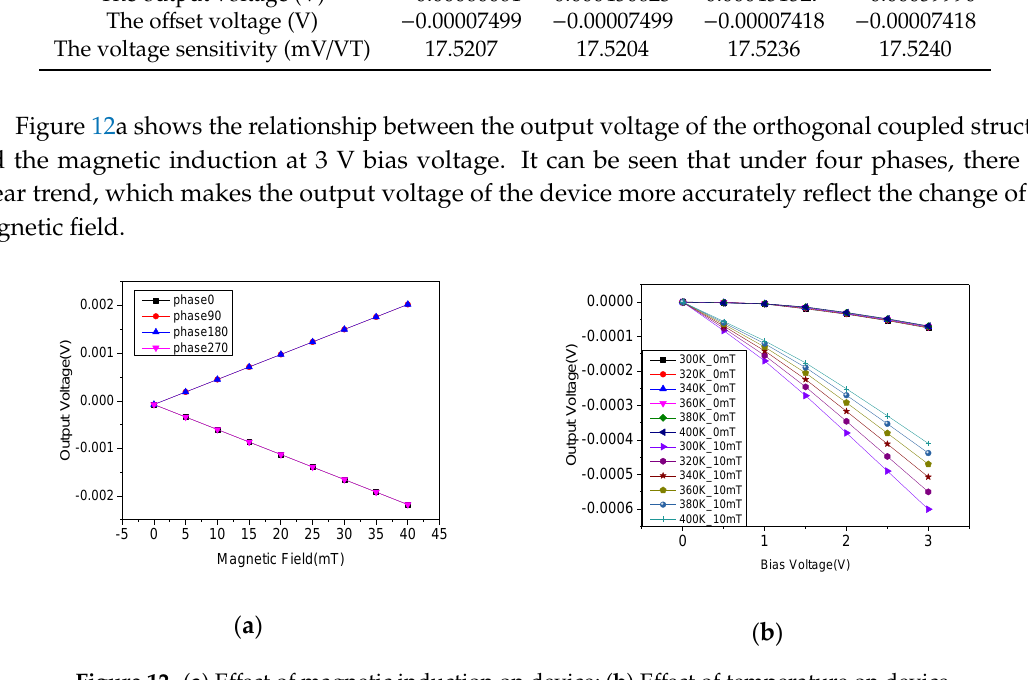
Table 2. The o ff set voltages and voltage sensitivity of the orthogonal coupled structure.